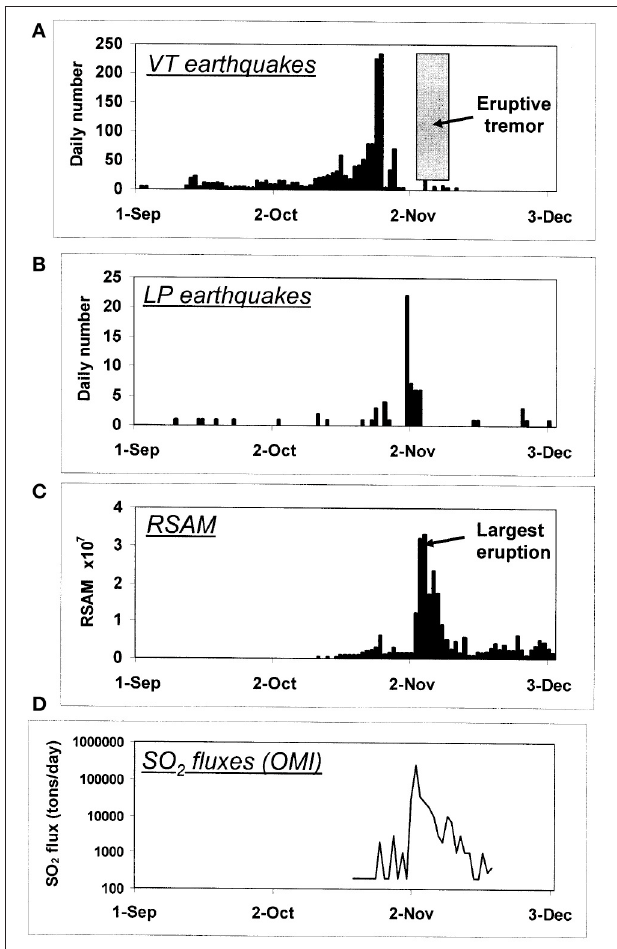
FIGURE 2 | Earthquakes and SO 2 fluxes at Merapi, September-November 2010. Note the appearance of volcanotectonic (VT) earthquakes in September 2010, their escalation in early-mid October, and their rapid decline by the end of October. Long-period (LP) earthquakes are clustered in latest October and earliest November. The paroxysmal eruptive phase during 3–5 November is associated with maximum RSAM, maximum SO 2 output, and the occurrence of eruptive tremor. Surono et al. (2012), Copyright 2012, with permission from Elsevier.